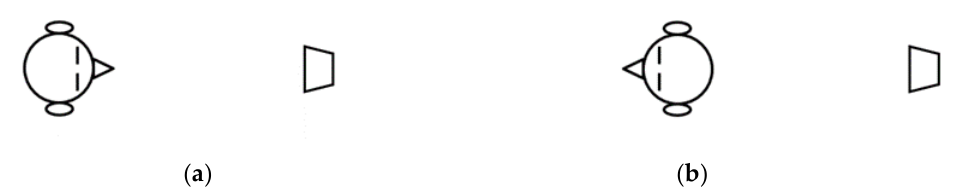
Figure 9. Effects on listening experience when the listener is ( a ) facing or ( b ) turning her or his back to the loudspeaker.